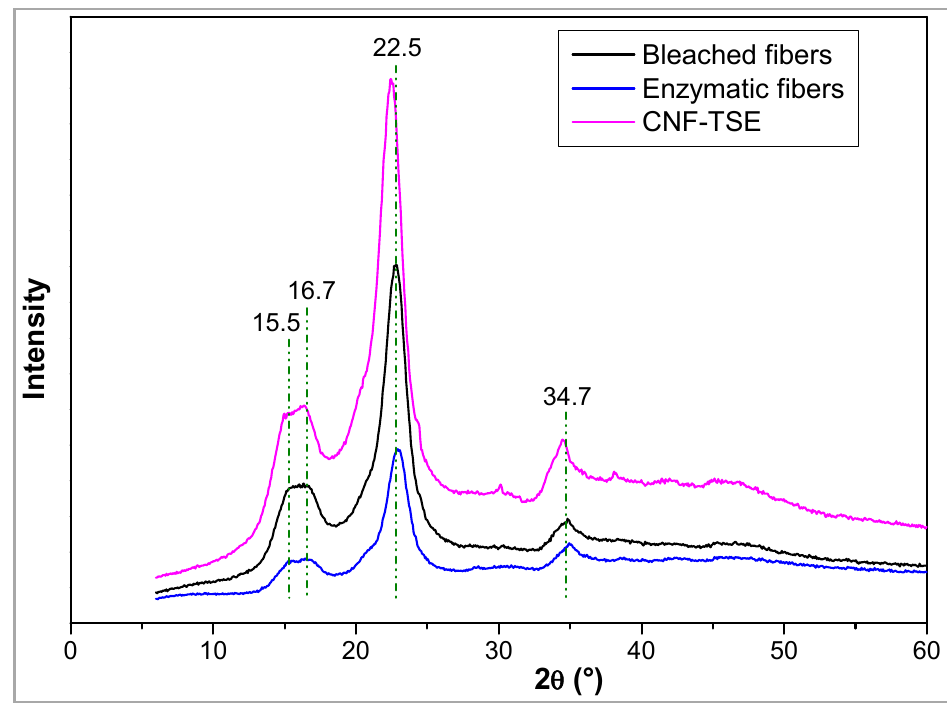
Figure 4. An example of XRD profiles of the bleached fibers, enzymatic fibers, and CNF–TSE. The average cross-sectional dimension of the elementary cellulose crystallites was determined from X-ray diffractograms by applying Scherrer’s expression (Equation (2)). Since Scherrer’s equation is restricted to samples of high crystallinity and without any broadening of the peaks, this estimated calculation was made only for CNF-TSE and CNF- M, and the values were 19 nm and 12 nm, respectively. The value seems to be very close to the obtained width, which was determined by optical observation (AFM and